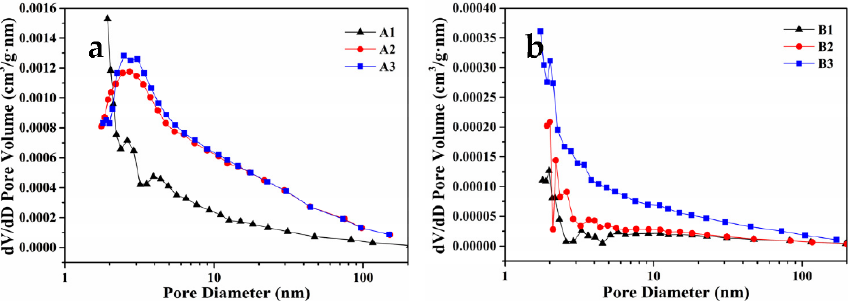
Figure 5. Pore-size-distribution curves of the mudstone ( a ) and coal ( b ) specimens with distinct granule diameters from the LT-N 2 A measurement.